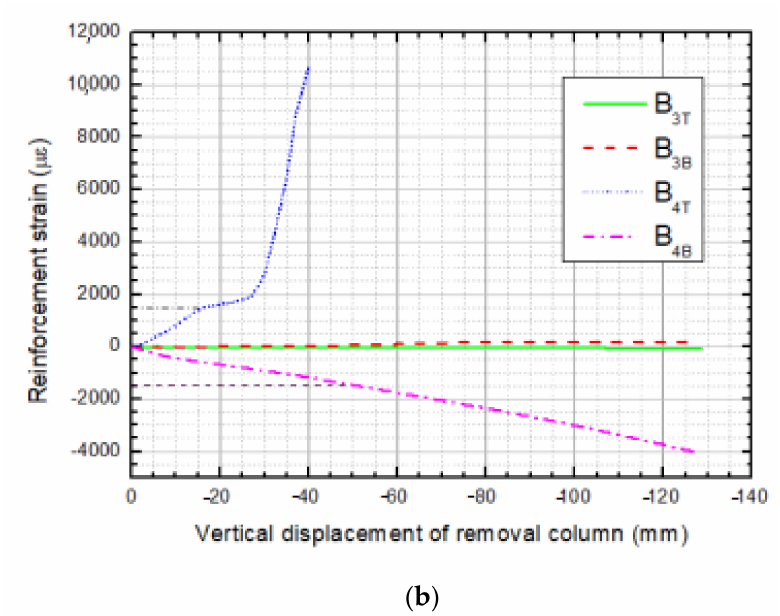
Figure 13. Reinforcement strain of beams in DAP, ( a ) reinforcement strain of beam LB-1, ( b ) rein- forcement strain of beam TB-1.